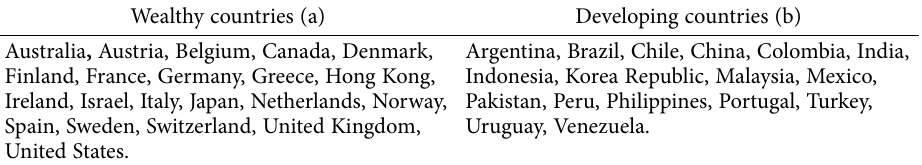
Table 1. Classification of countries according to per capita income level Wealthy countries (a) Developing countries